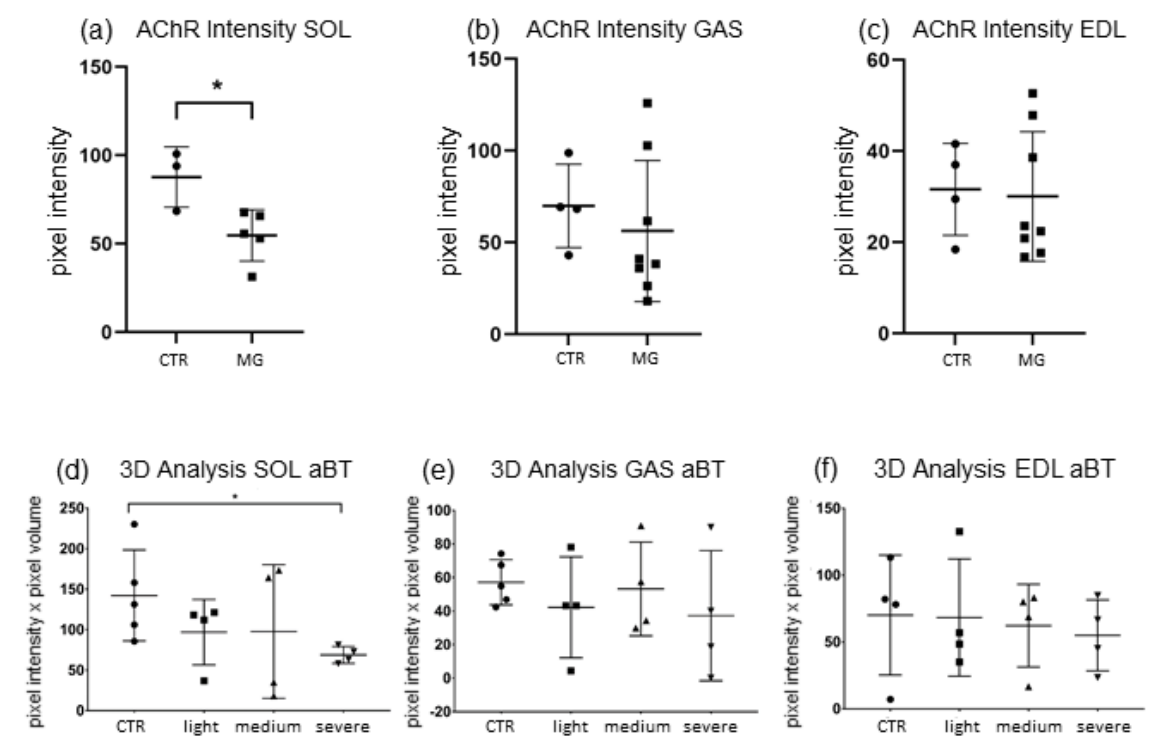
Figure 2. nAChR degradation rate in endplates of hindlimb muscles EAMG vs. CTR ( a – c ) and 3D-analysis of endplate nAChR-volume and pixel intensity, divided by clinical disease severity ( d – f ). Results of confocal pixel intensity analysis, Alpha Bungarotoxin (αBTX) staining. ( a ) Significant decrease in pixel intensity was present in SOL (−40.8%, p ≤ 0.033) of EAMG. ( b ) No significant changes were present in EDL and ( c ) GAS . ( d ) nAChR-amount was reduced significantly in SOL (48.2 %, p ≤ 0.0159) in severely affected mice. ( e ) No significant decrease was present in GAS and ( f ) in EDL . Data are express as means ± SD. For each experimental group, n = 4 male C57BL/N6 mice (28 weeks old). Statistical differences between groups were determined by Mann – Whitney-U-Test. * = indicates significant difference vs. CTR (ANOVA p ≤ 0.05). * indicates significant difference vs . CTR.